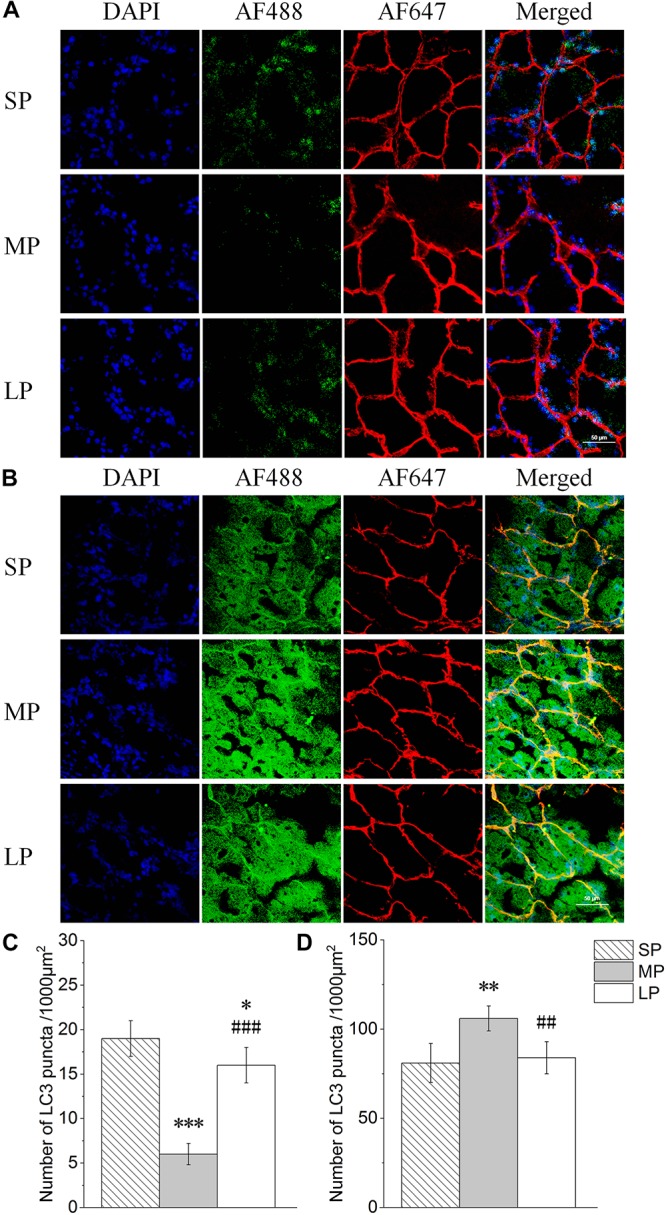
Quantification of LC3 and P62 puncta of HG in hamsters in three photoperiodic groups. (A) Immunofluorescence histochemistry showing LC3 puncta. Blue represents 4′6′-diamidino-2-phenylindole (DAPI)-stained nucleus, red represents Alexa Fluor 647-stained laminin of interstitial tissue, green represents AF488-stained LC3. Scale bar = 50 μm. (B) Immunofluorescence histochemistry showing P62 puncta. Blue represents 4′6′-diamidino-2-phenylindole (DAPI)-stained nucleus, red represents Alexa Fluor 647-stained laminin of interstitial tissue, green represents AF488-stained P62. Scale bar = 50 μm. (C) Quantification of LC3 puncta. (D) Quantification of P62 puncta. Six figures were analyzed in each sample; ten samples were analyzed in each group. Values are means ± SD. SP, short photoperiod; MP, moderate photoperiod; LP, long photoperiod.∗P < 0.05, ∗∗P < 0.01, ∗∗∗P < 0.001 compared with SP; ##P < 0.01,###P < 0.001 compared with MP.